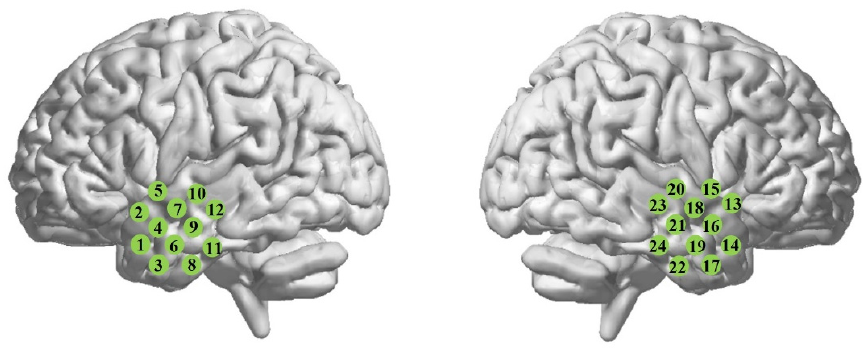
Figure 1. Schematic representation of channel locations on the bilateral temporal lobes.